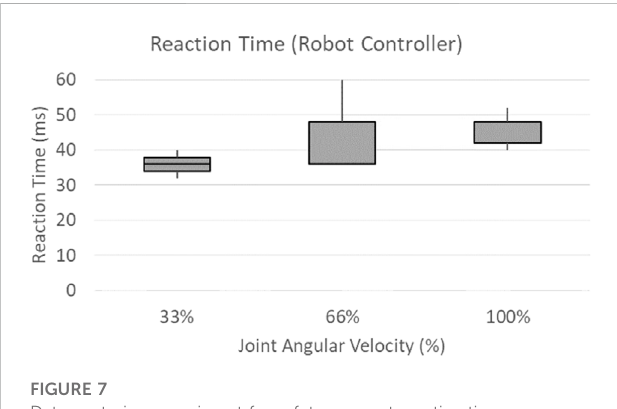
FIGURE 7 Data capturing experiment for safety parameter